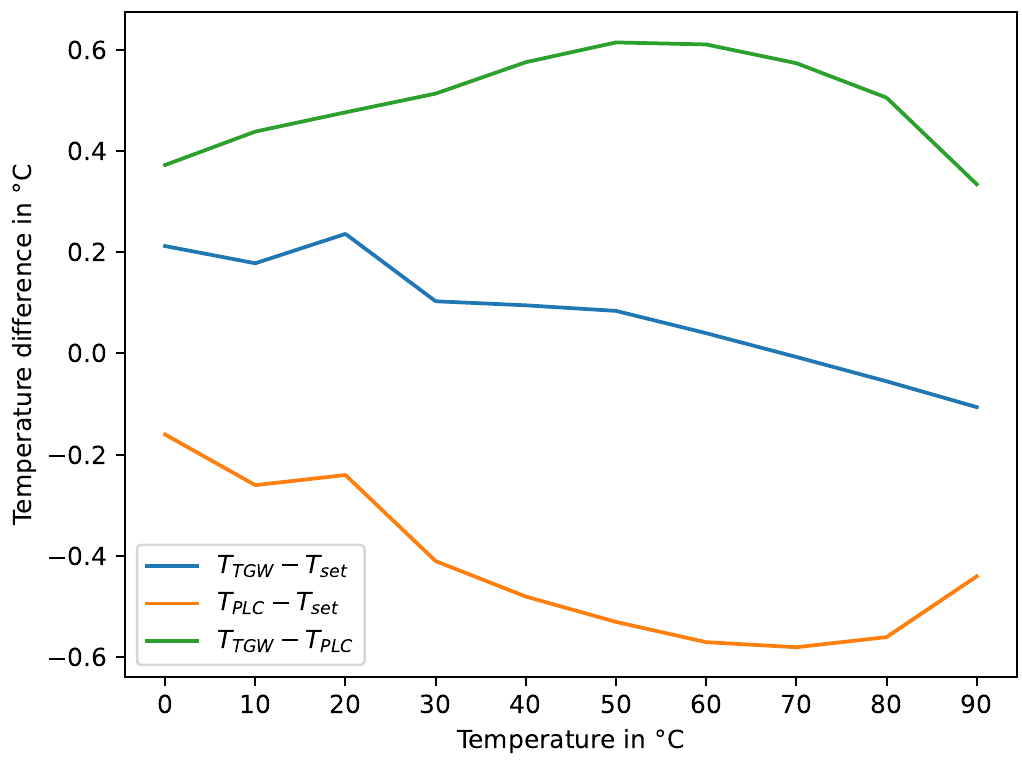
Figure 9. Development of temperature deviations between the TGW and the set temperature in blue, between the PLC and the set temperature in orange, and between the TGW and the PLC in